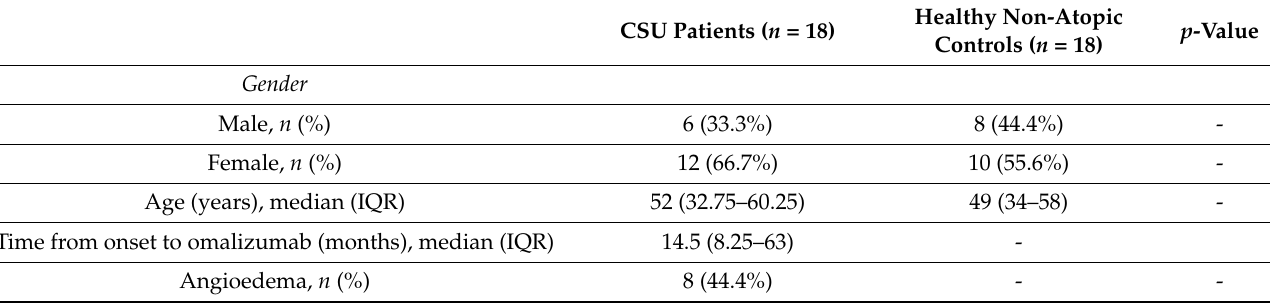
Table 1. Clinical and laboratory features of chronic spontaneous urticaria (CSU) patients and healthy non-atopic controls. IgE = Immunoglobulin E; IQR = interquartile range; LTC4 = leukotriene C4; OD = optical density. Statistically significant p -values are in